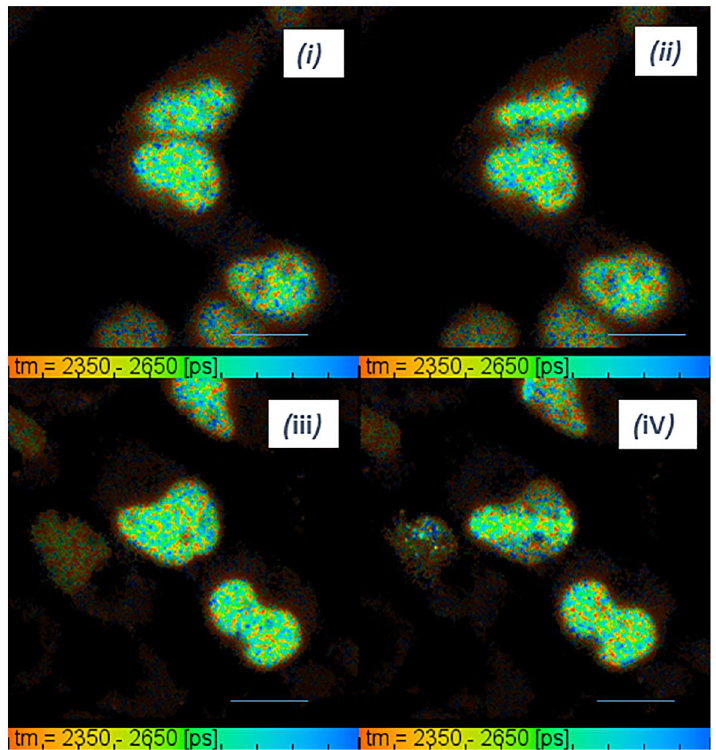
Figure 6. Multiphoton excitation at 730 nm, (5 mW average power), shows small viscosity change in V15B mammalian cells expressing Ku80-GFP fluorescent protein. FLIM of cells before laser microbeam irradiation (i and iii). FLIM after milliwatts irradiation (ii and iv). Only small shift in GFP lifetime indicating some viscosity change unlike the one-photon excitation. Scale bar 10 µm.